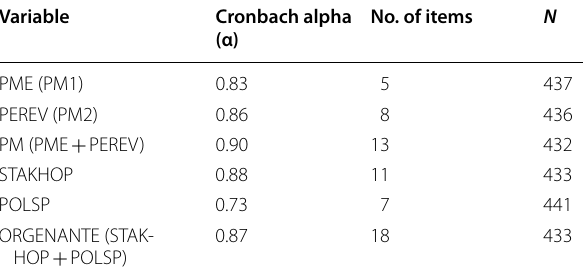
Table 3 Summary results of reliability